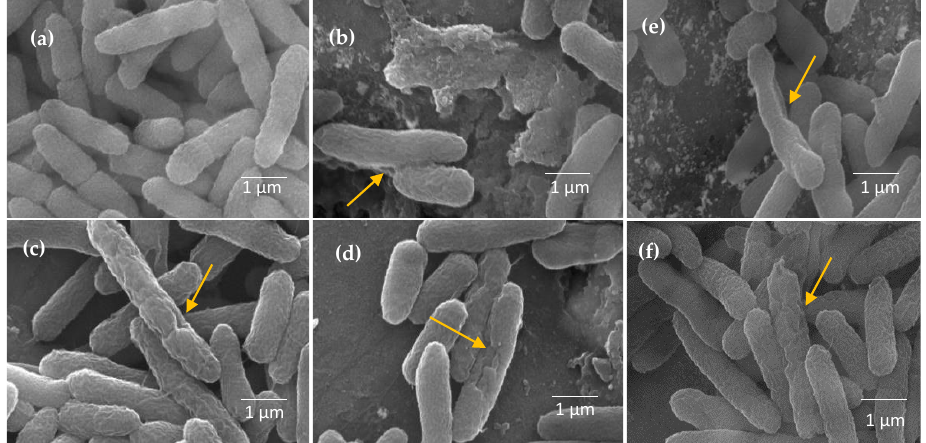
Figure 9. SEM images showing the status of cell morphology and membrane integrity of the bacterial cells treated with Al 2 O 3 ( a ), Al-Zn 10 -3 ( b ), Al-Fe 10 -3 ( c ), Al-Cu 10 -3 ( d ), Al-Ga 10 -3 ( e ) and Al-Bi 10 -3 ( f ) (yellow arrows show the cell membrane ruptures).